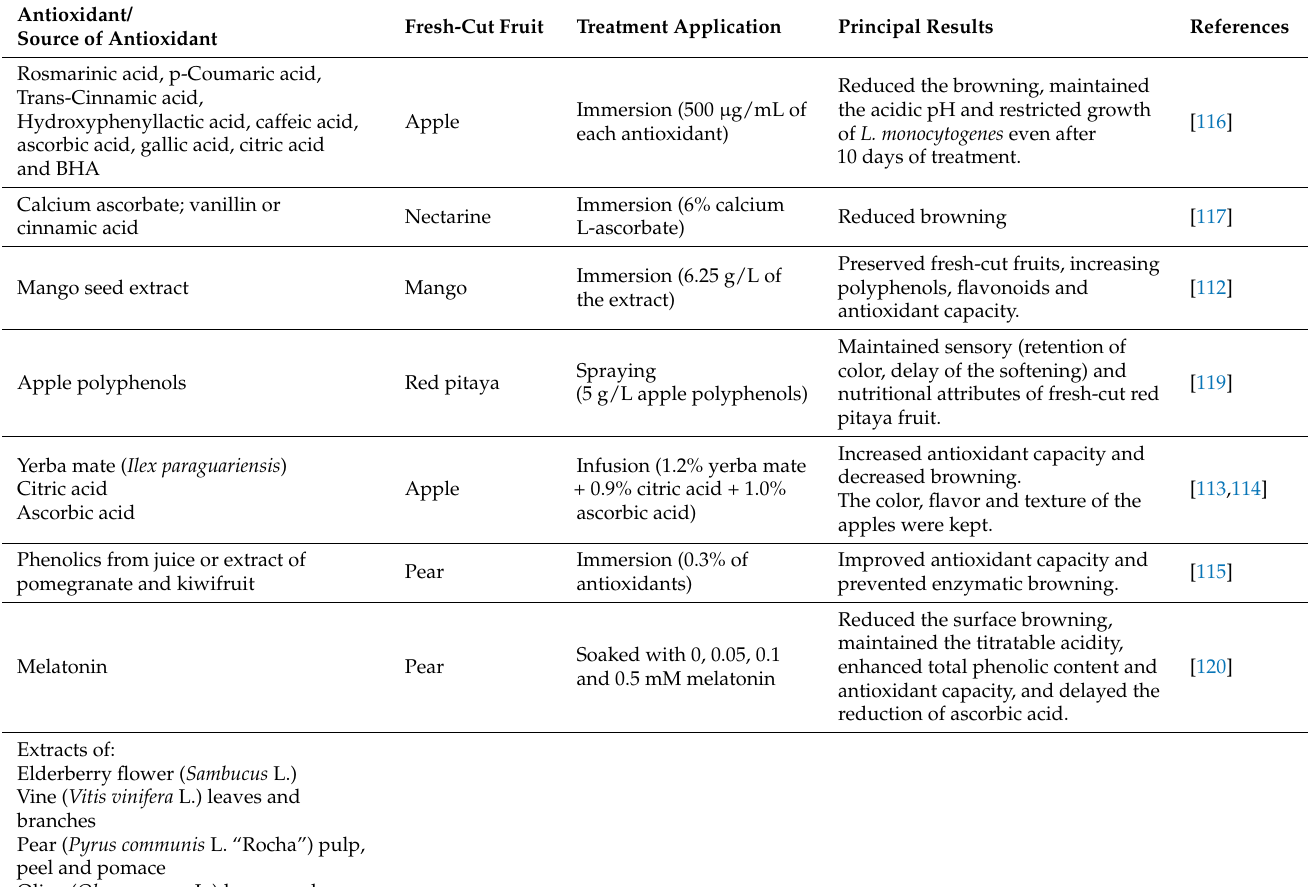
Table 3. Effects of pure or extracted antioxidant compounds on the quality of fresh-cut